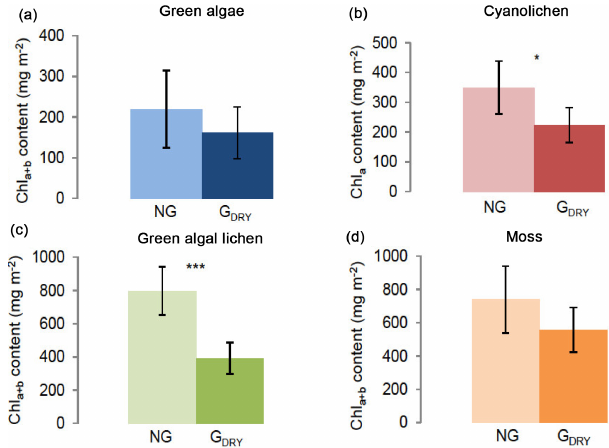
Figure 1. Chlorophyll a + b /chlorophyll a content (mgm − 2 ) of green algae- (a) , cyanolichen- (b) , green algal lichen- (c) , and moss-dominated biocrusts (d) using the DMSO and ethanol extrac- tion method. To prove statistical differences between both extrac- tion methods, the Mann–Whitney U test was performed for moss- dominated biocrusts (data not normally distributed), for the other three biocrust types a Welch test was performed (data without ho- mogeneity of variance) ( ∗ p ≤ 0 . 05; ∗∗ p ≤ 0 . 01; ∗∗∗ p ≤ 0 . 001).